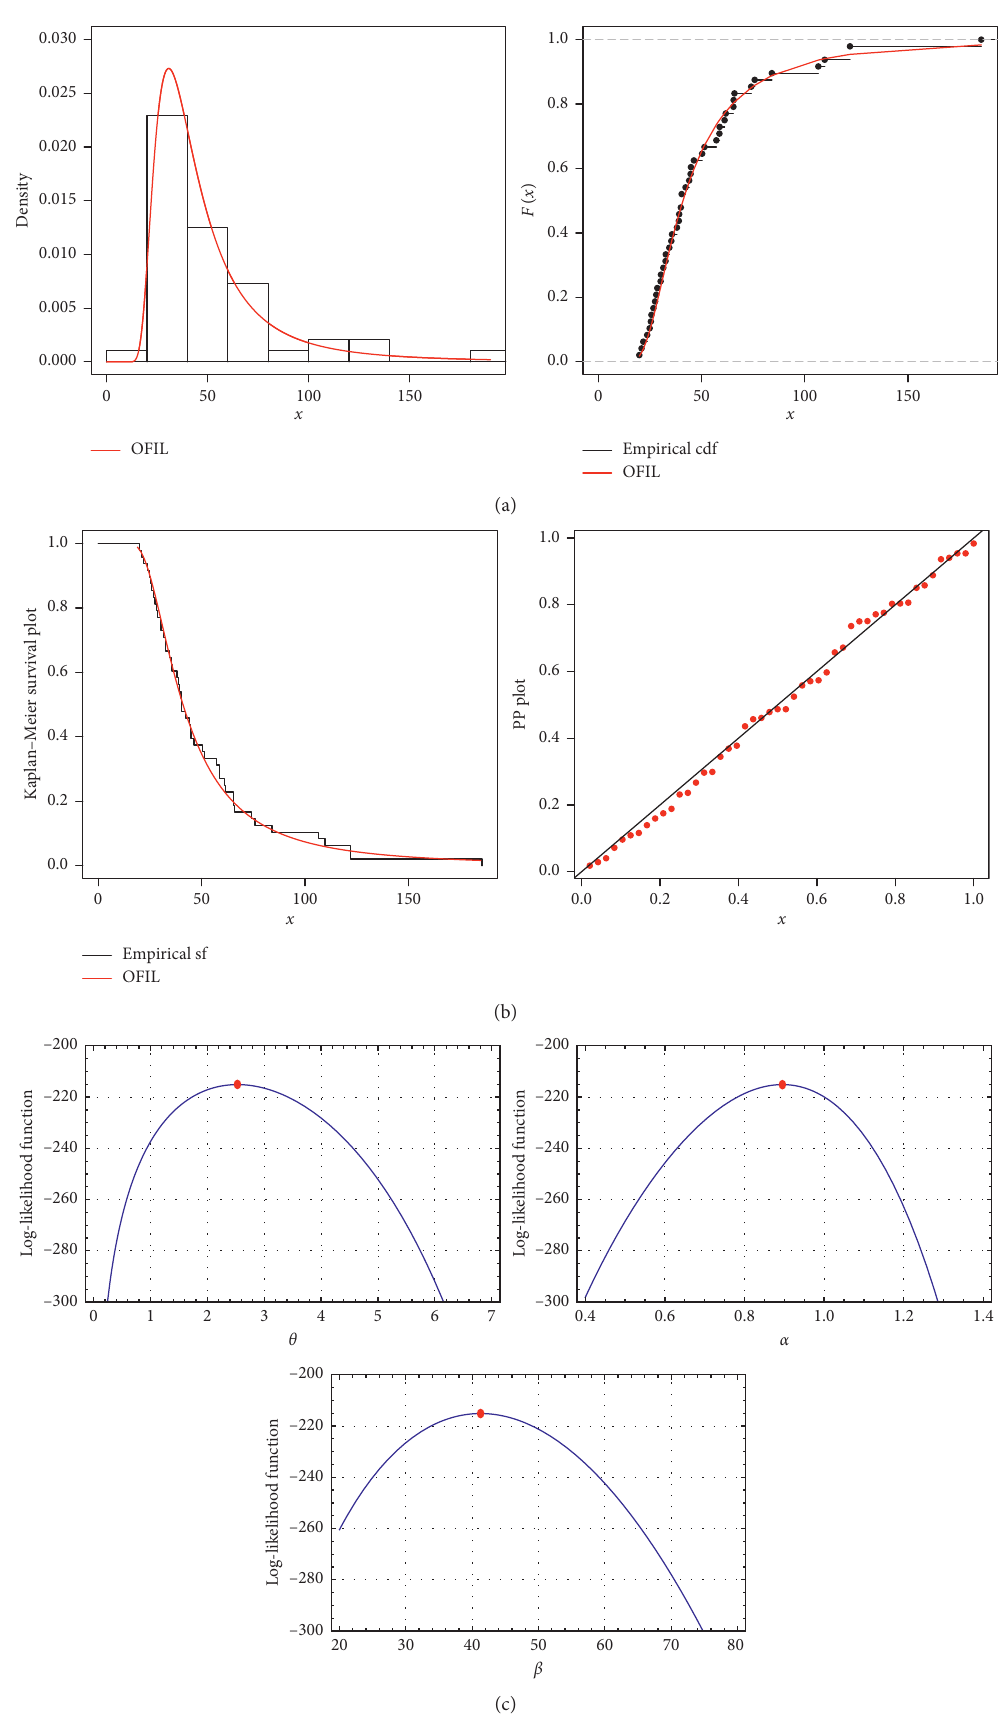
Figure 5: (a) Plots of the estimated pdf and cdf for data set I. (b) Plots of the estimated sf and PP plot for data set I. (c) Log-likelihood plots for data set